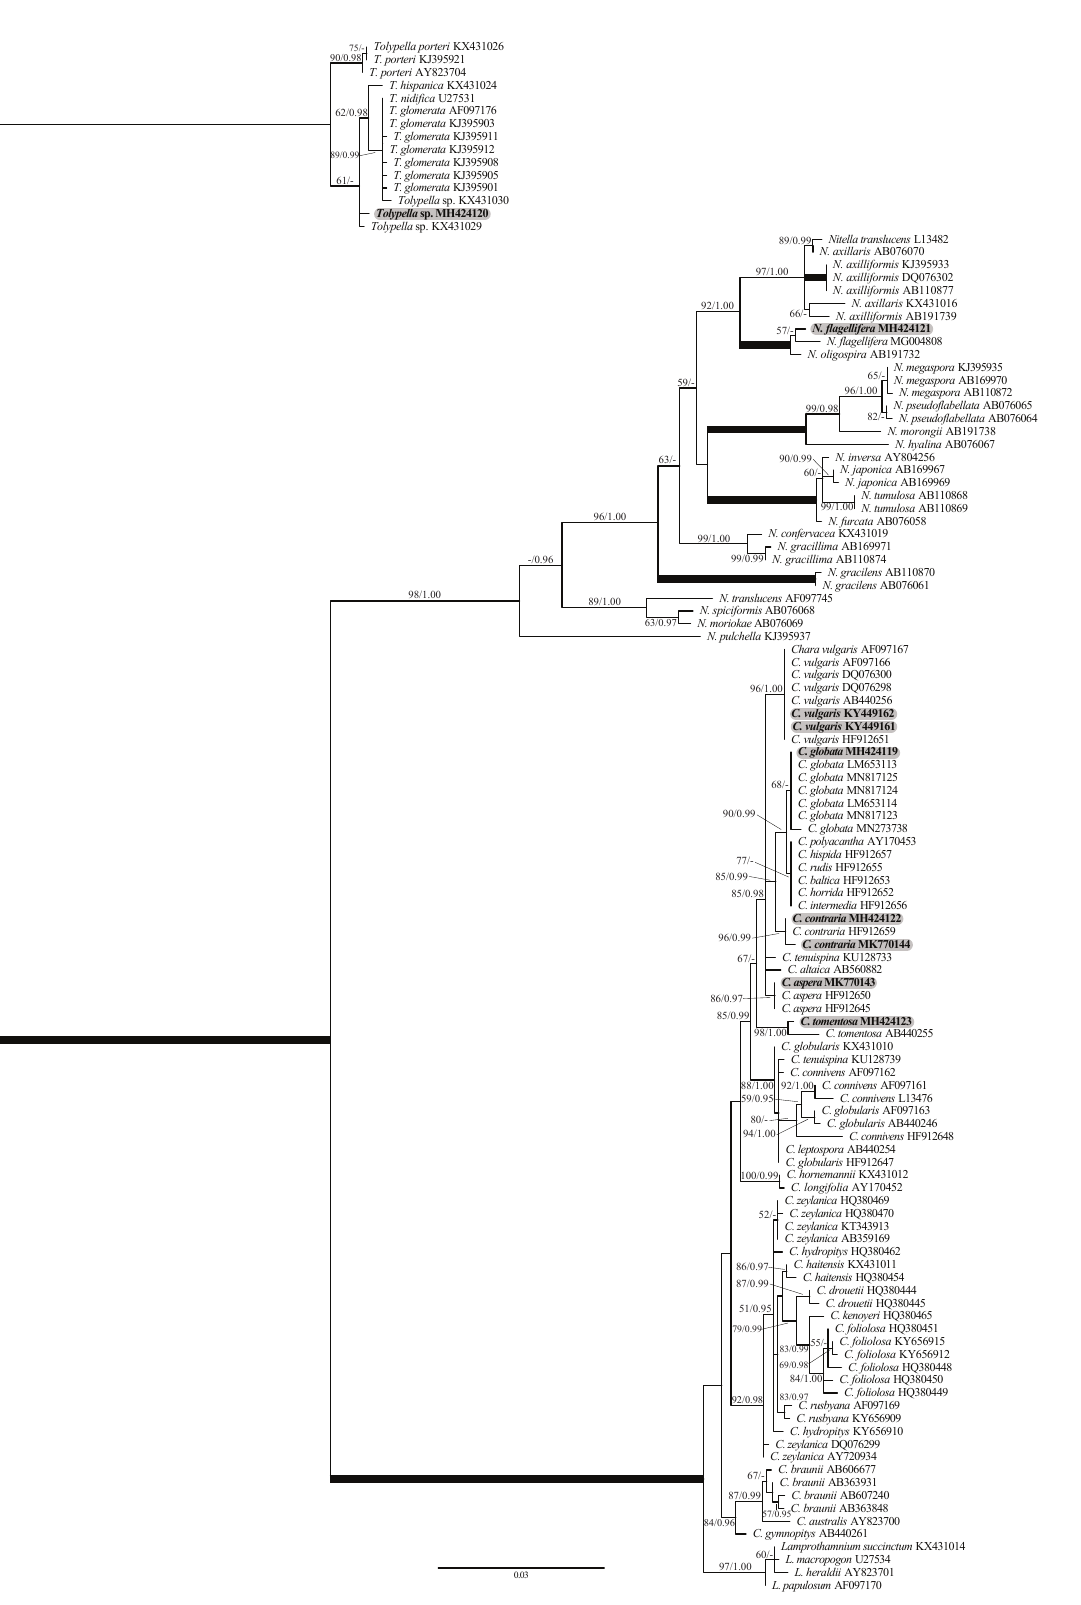
Figure 1. Phylogeny of Characeae based on 121 rbc L sequences of Chara , Nitella , Tolypella , and Lamprothamnium . ML tree was inferred in PAUP with GTR+I+G nucleotide substitution model with maximum likelihood bootstrap values (>50%) and posterior probabilities (>0.95) shown at branches. Branches received 100% BP and 1.00 PP support, and the newly obtained sequences are shown in